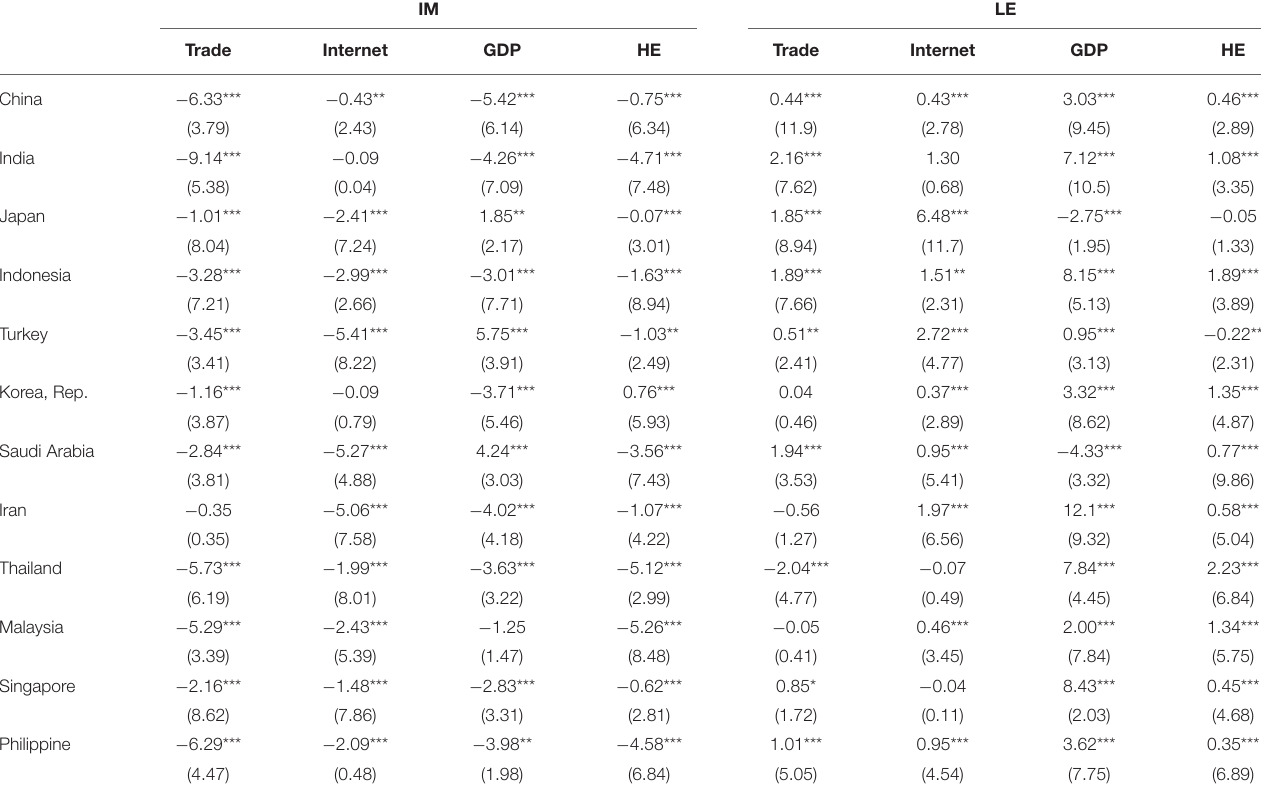
TABLE 5 | Economy-wise estimates of